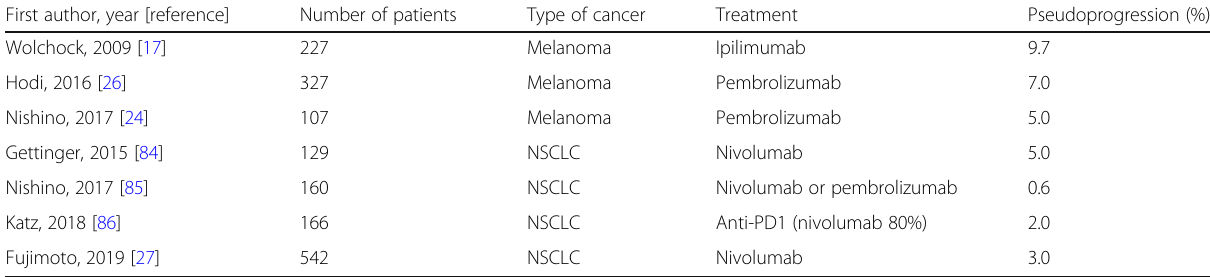
Table 2 Rate of pseudoprogression in patients with melanoma or